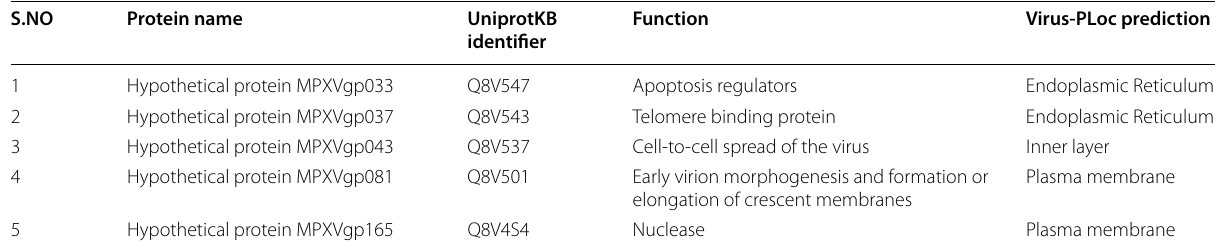
4 software prediction) and subcellular localization ≥